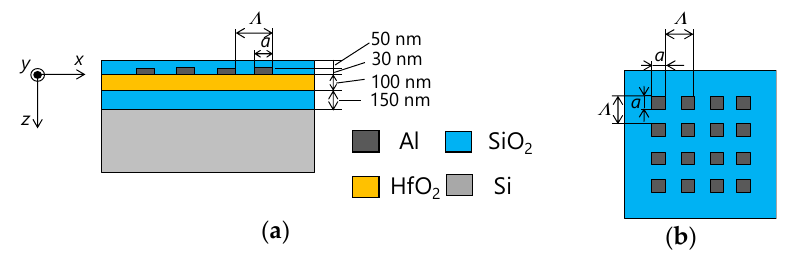
Figure 2. Calculation model of one color filter element. ( a ) Cross-sectional view; ( b ) top view.